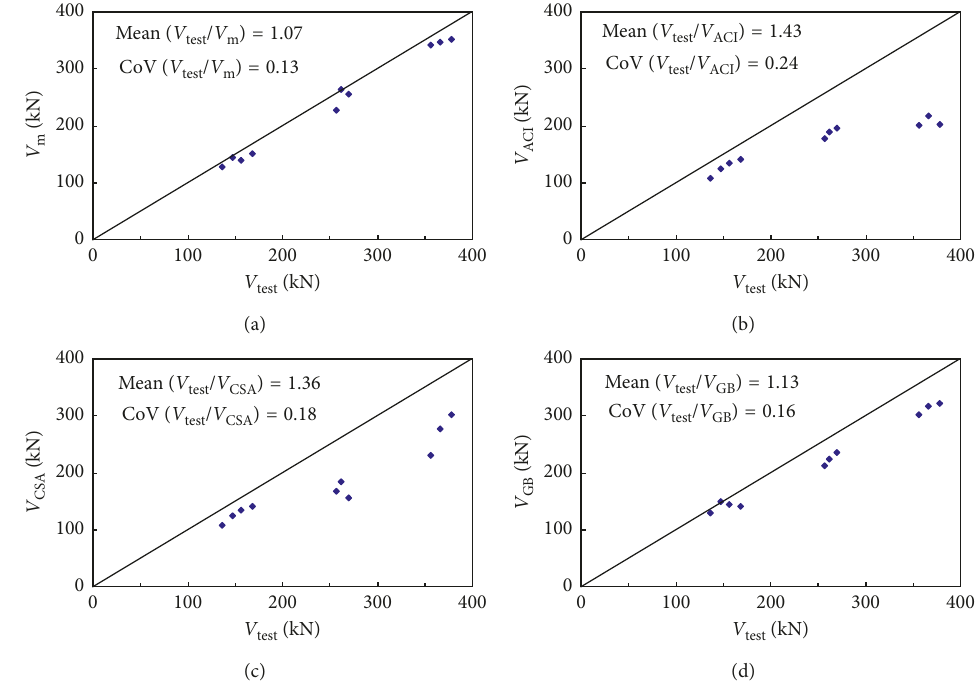
Figure 8: Comparison of experimental and other methods: (a) proposed model; (b) method in ACI318 (2008); (c) method in CSA (2004); (d) method in GB50010